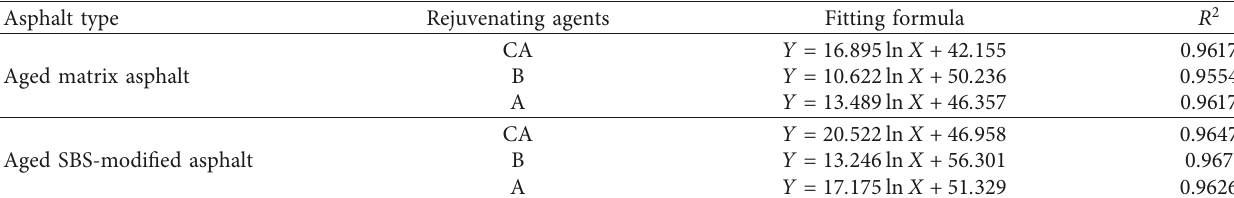
Figure 11: Softening point curves of aged asphalt after adding rejuvenating agents at a certain penetration depth: (a) recycled matrix asphalt; (b) recycled SBS-modified asphalt. Table 5: Softening point fitting